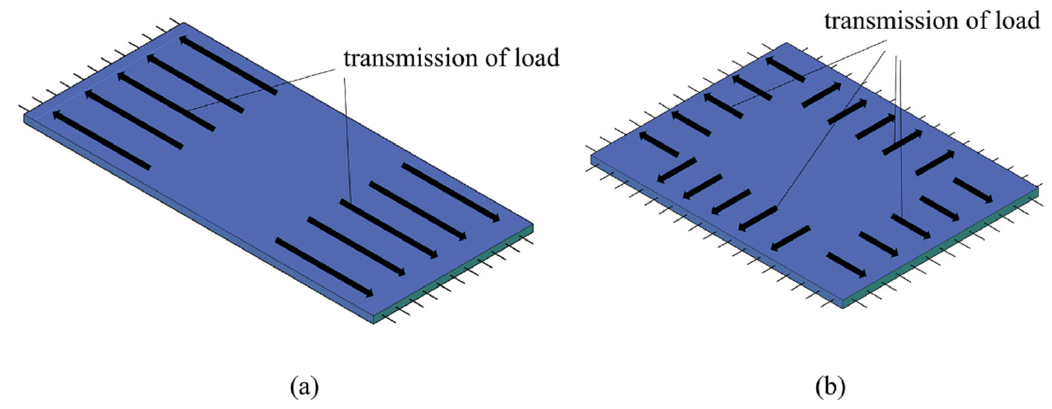
Figure 1. Schematic diagram of floor slab: ( a ) one-way slab, ( b ) two-way slab. The vertical load-bearing units are formed by four types of prefabricated cantilever components that are made of reinforced concrete and innovatively designed: standard H-shaped components, corner L-shaped components, T-shaped components, and cross- shaped components, as shown in Figure 2a–d, respectively.